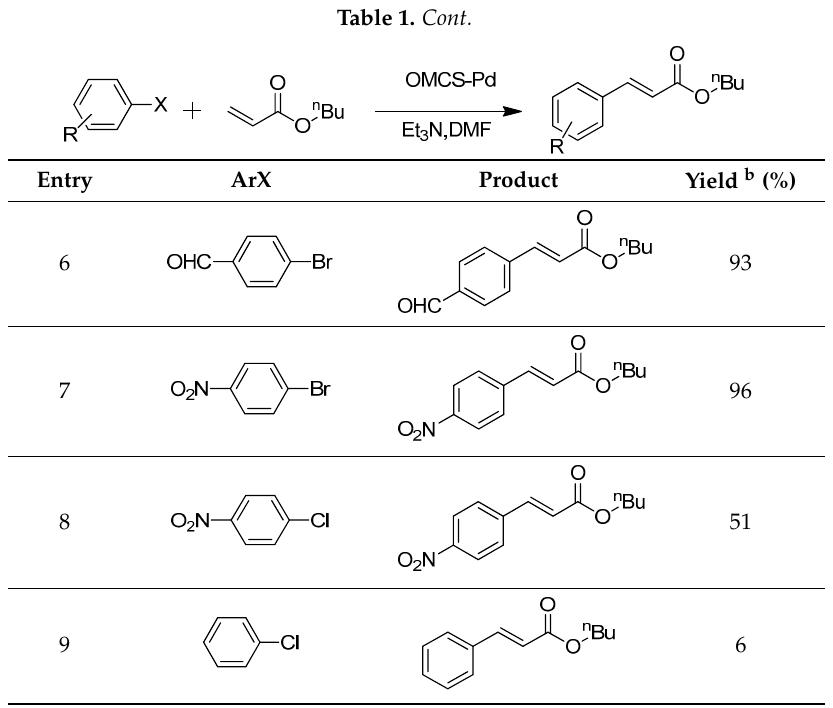
Table 1. Cont. Table 1. Heck reaction of aryl halides and n -butyl acrylate catalyzed by OCMCS-Pd a .